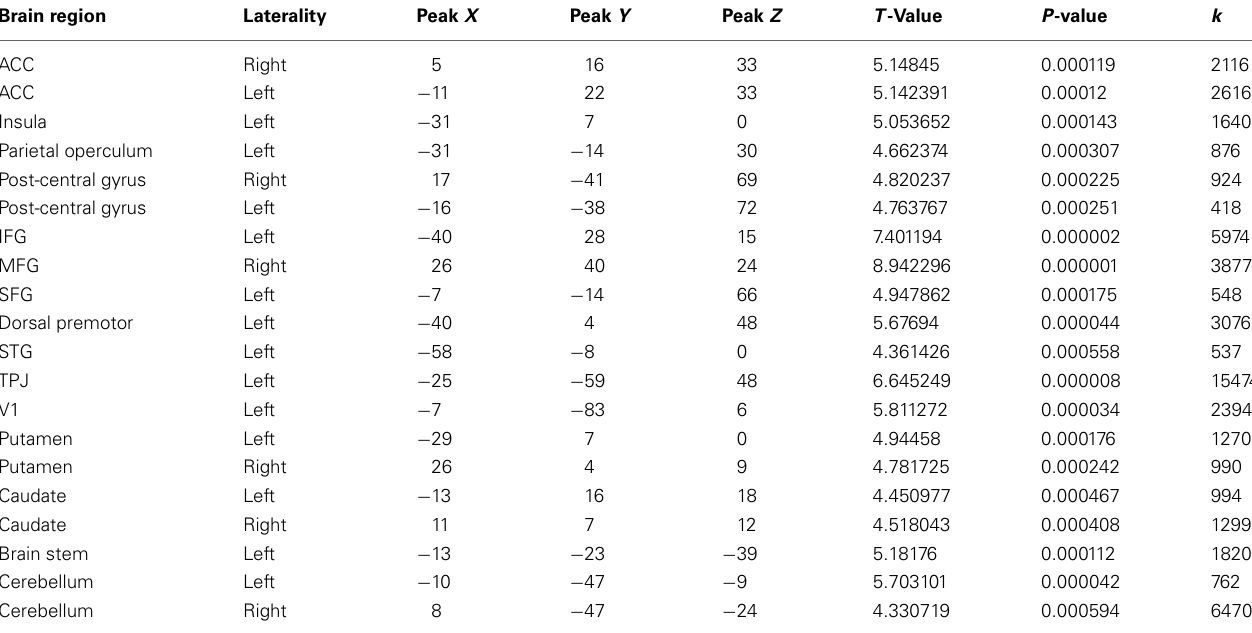
FIGURE 4 | Regions showing significant activity for viewing hateful people in pain compared with likable people in pain, thresholded at p < 0 . 05, FDR corrected. The sagittal slice ( x = − 35) shows activity in left hemisphere’s anterior insula, middle frontal gyrus, posterior parietal, and Table 3 | Brain regions showing a significant difference in processing hateful people in pain to processing likable people in pain ( p < 0 . 05, FDR